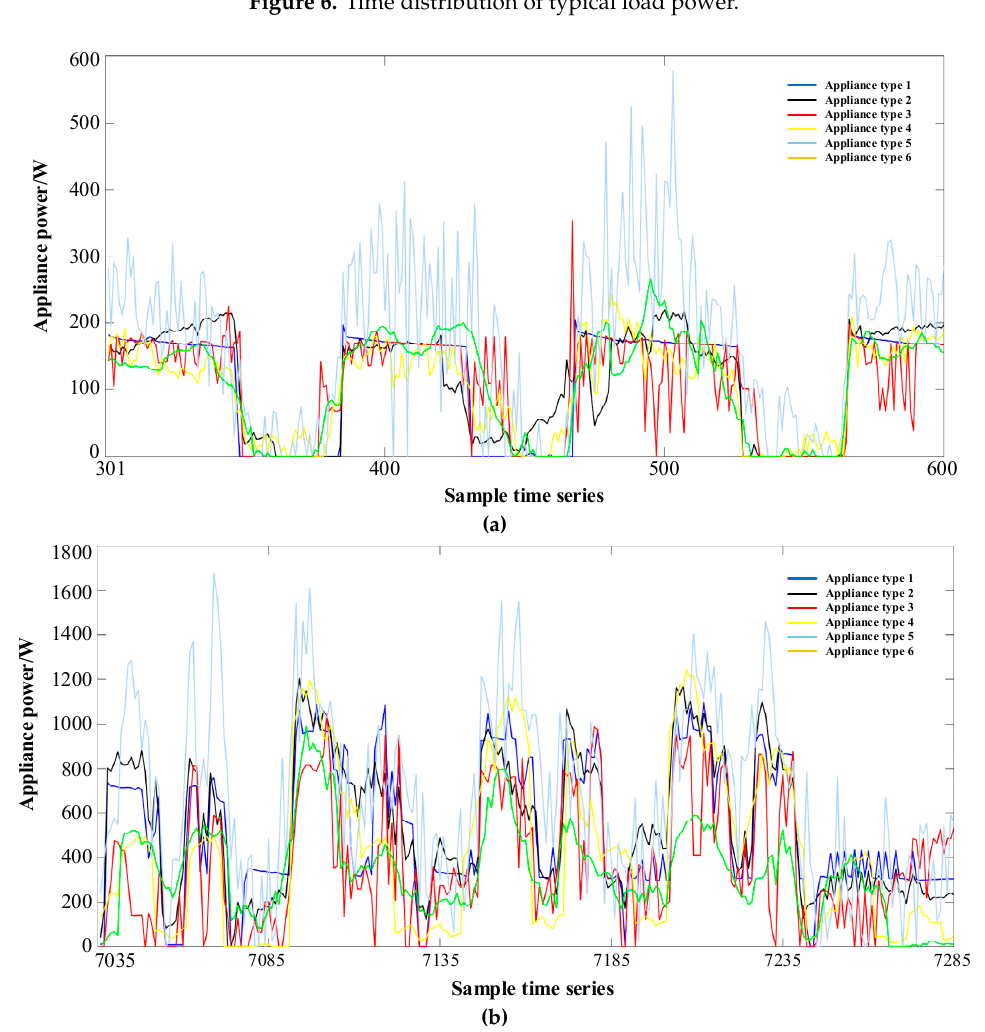
Figure 7. Power decomposition of different types of electrical appliances. (a) Refrigerator; (b) Microwave